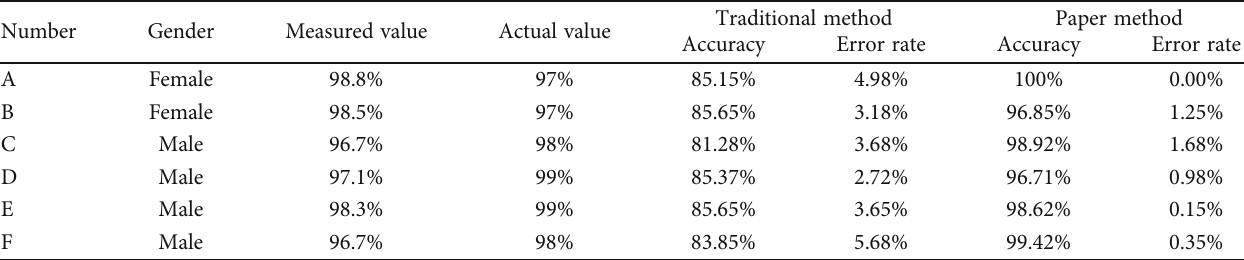
Table 8: Comparison of big data blood oxygen evaluation